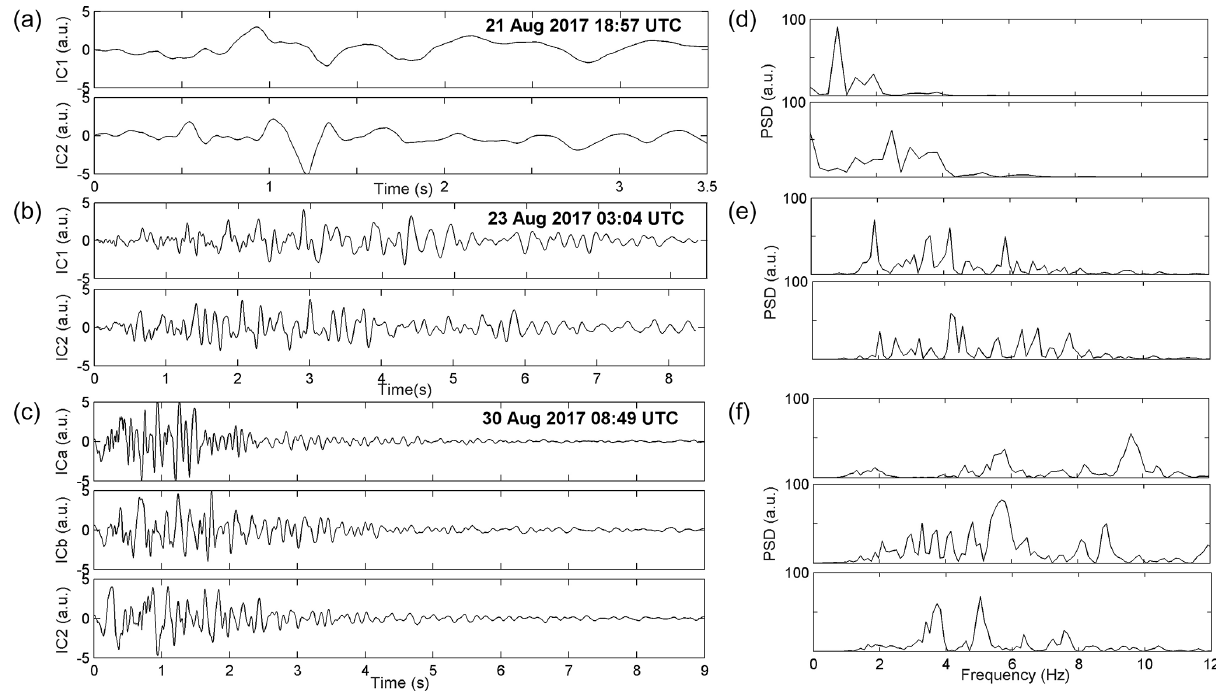
Figure 3. ICA results for Ischia earthquakes: in panels (a) , (b) , (c) , the ICs are reported with the indication of the date and time; in panels (d) , (e) , (f) , the corresponding Power Spectral